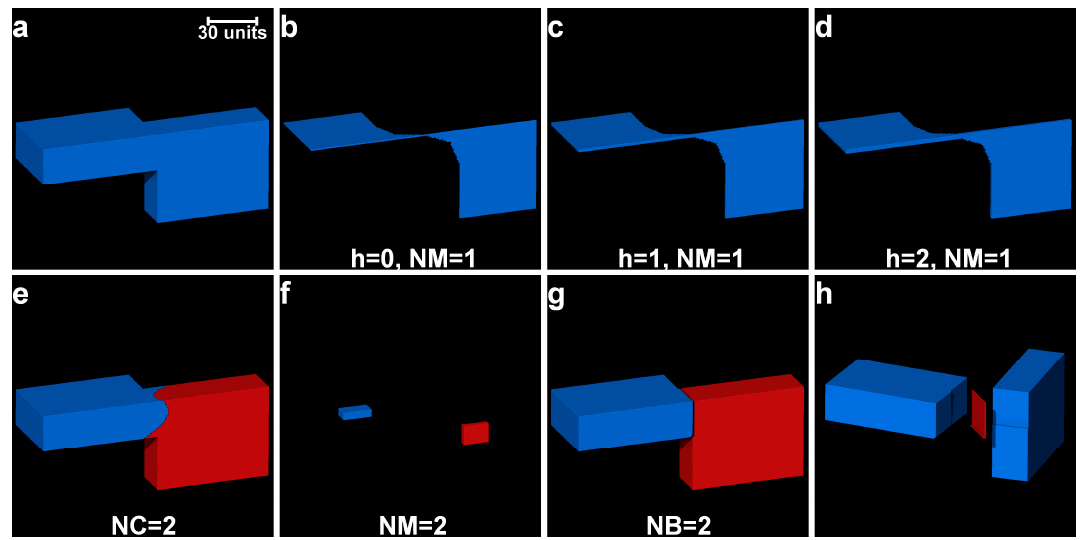
Figure 7. Separation of three blocks using the GMM clustering: ( a ) clusters; ( b ) extracted markers; ( c ) markers imposed on the blocks; and ( d ) separated blocks.